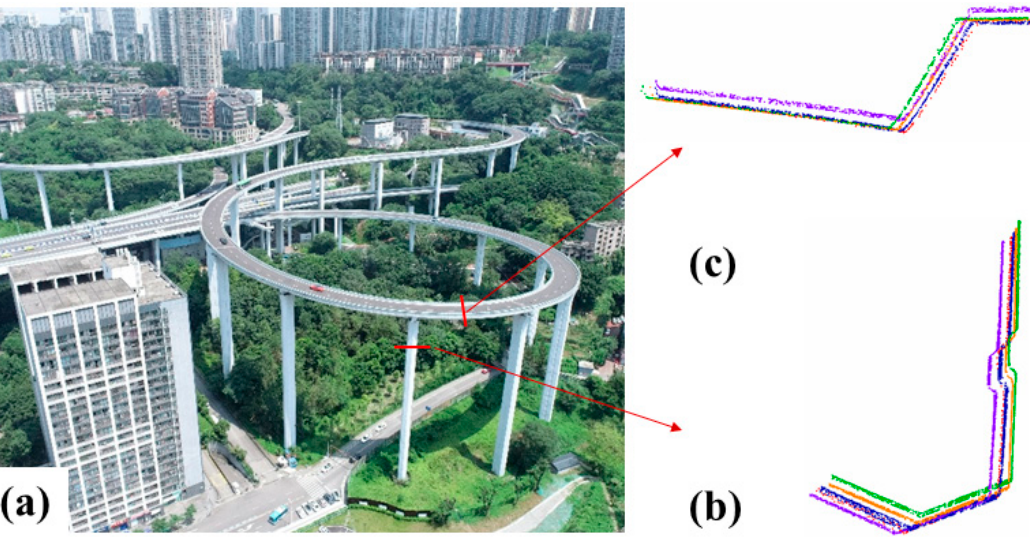
Figure 12. Comparison of enlarged registration results of Sujiaba Bridge based on four methods. ( a ) UAV image of Sujiaba Bridge. ( b ) Enlarged details of specified cross-section in bridge piers with top view. ( c ) Enlarged details of specified cross-section in main girders with side view. The target point cloud is shown in red. The result of FPFH, SHOT, RoPS, and our descriptor is shown in purple, orange, green, and blue, respectively.